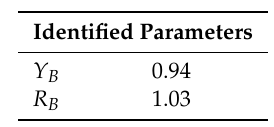
Table 3. The values of identified parameters using a heterogeneous test response.